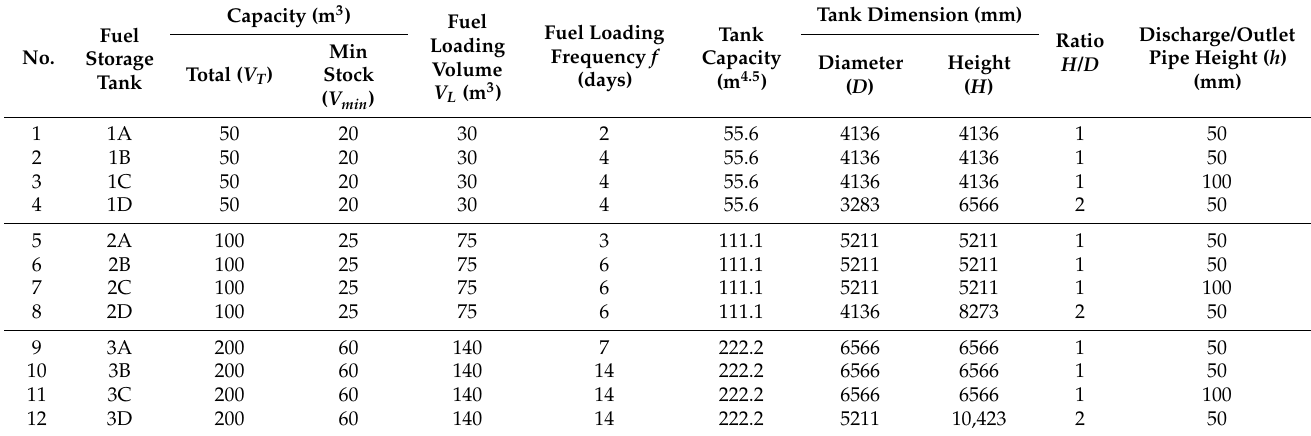
Table 1. B20 storage tank conditions for simulation of sludge removal schedule from fuel storage tank.